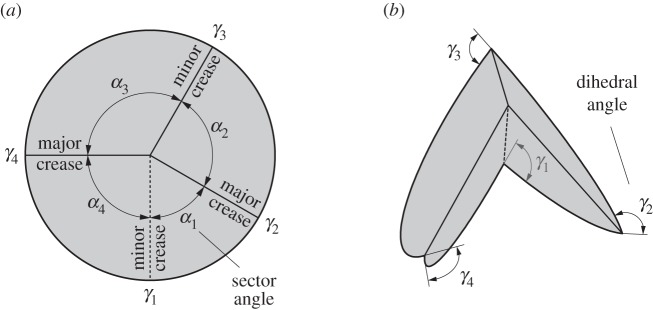
A degree-4 origami vertex in its (a) unfolded and (b) partially folded states. Mountain folds are indicated by solid lines and valley folds by dashed lines.